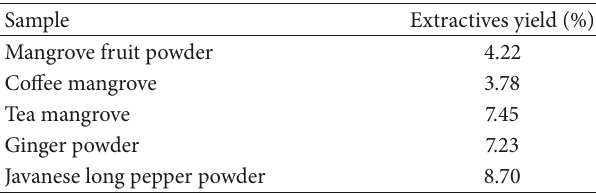
Table 1: Methanol extractive yields of the samples.